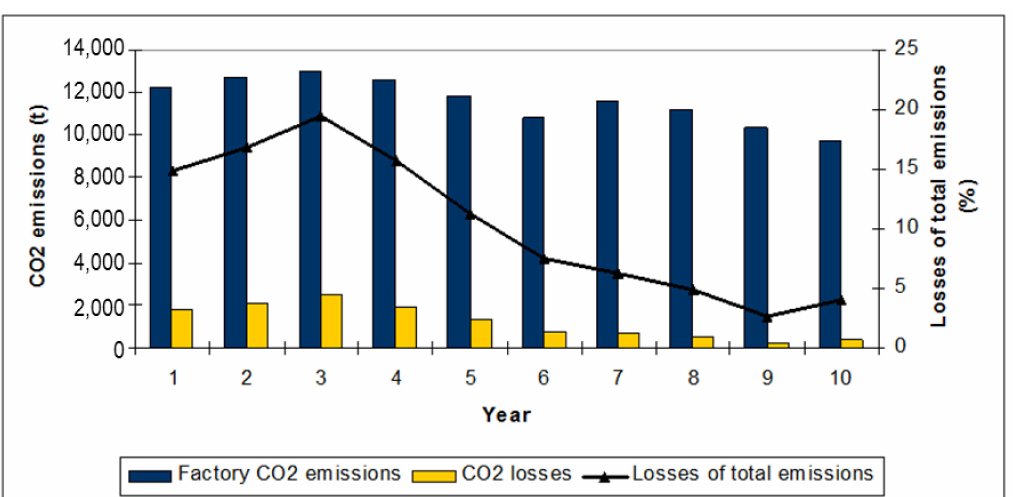
Figure 4. Yearly CO 2 emissions and CO 2